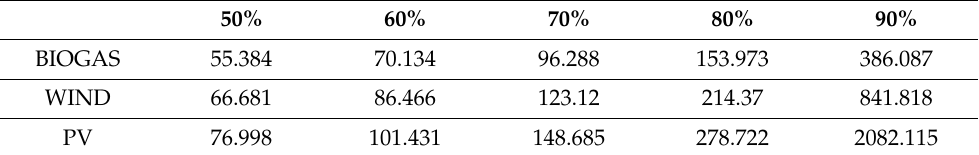
Table 5. The α coefficients defining the shape of the curve.